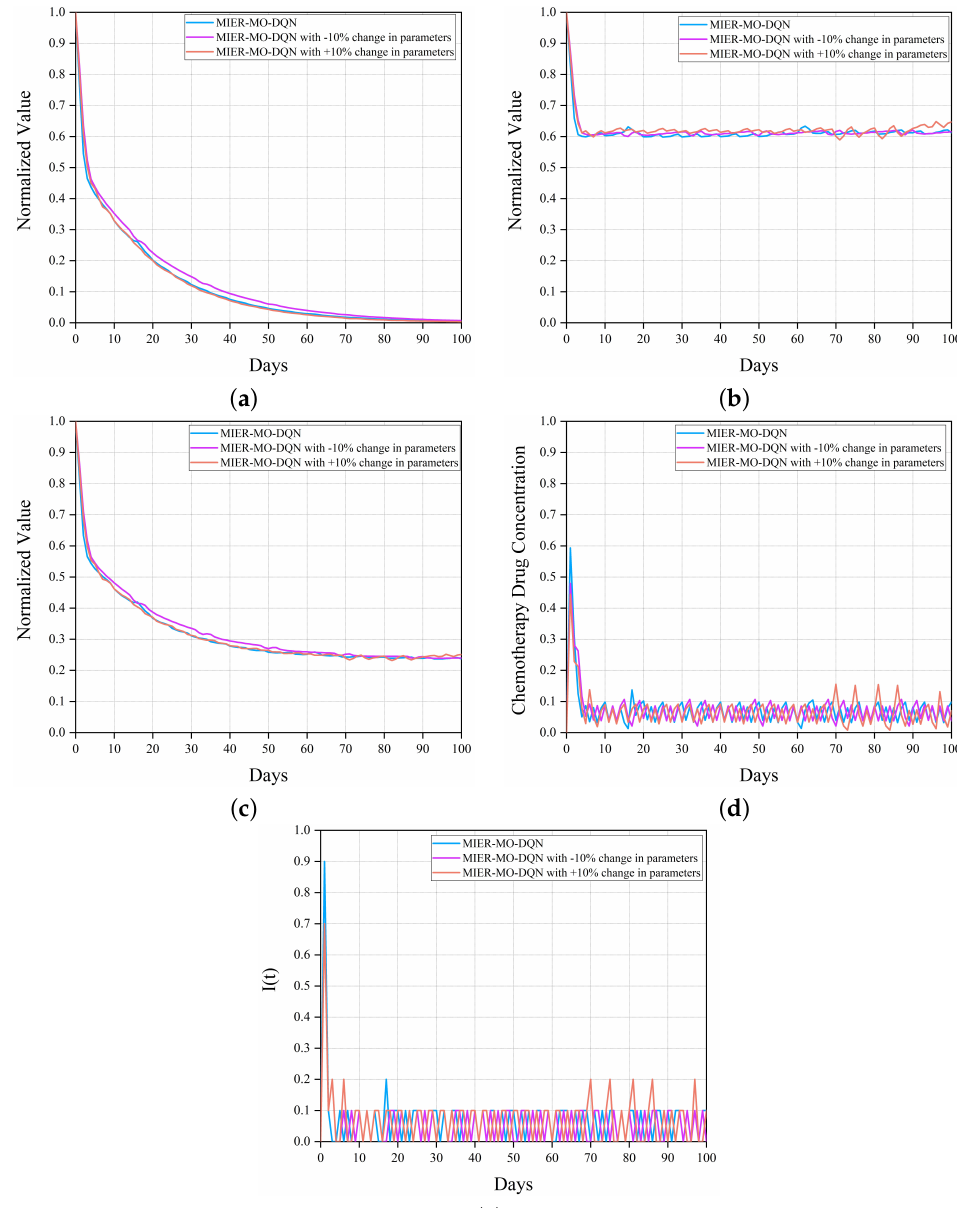
Figure 7. The change of ( a ) tumor cells, ( b ) effector-immune cells, ( c ) circulating lymphocytes, ( d ) drug concentration, ( e ) drug dose, according to different parameters on cells in